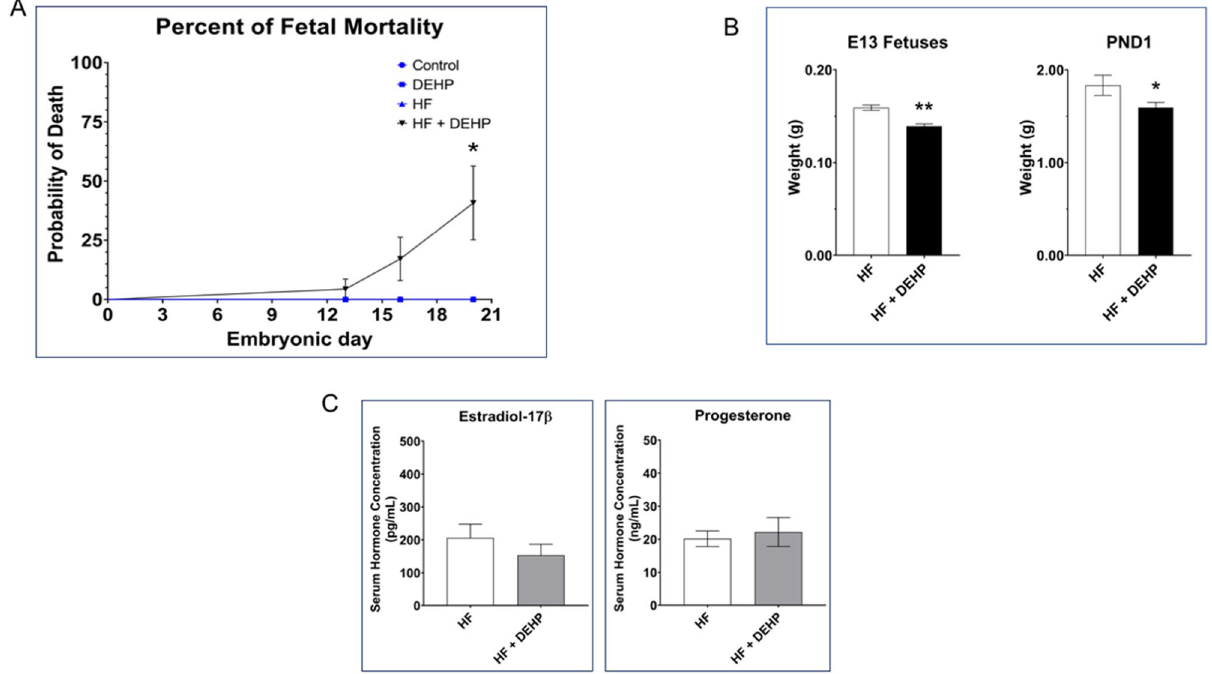
Figure 1. Exposure to DEHP and a HF diet during pregnancy affects fetal growth and mortality. ( A ) Female mice from day 1 of pregnancy were fed normal diet (control) or normal diet and exposed to 20 μg/kg/day of DEHP (DEHP), HF diet (HF) or HF diet and exposed to 20 μg/kg/day of DEHP (HF + DEHP) as described in the Materials and Methods. Fetal mortality was determined on D13 of pregnancy, D16 of pregnancy, and at the end of gestation. N = 8 /pregnancy day and the data are represented as the mean of pups pooled from 8 animals in each group. ( B ) Fetal weights were measured on D13 and postnatal day 1. N = 8 /pregnancy day and the data are represented as the mean of pups pooled from 8 animals in each group. ( C ) Serum hormone levels of progesterone and estrogen were determined in HF and DEHP + HF animals on D16 of gestation. Asterisks indicate statistically significant differences *p < 0.05, **p <